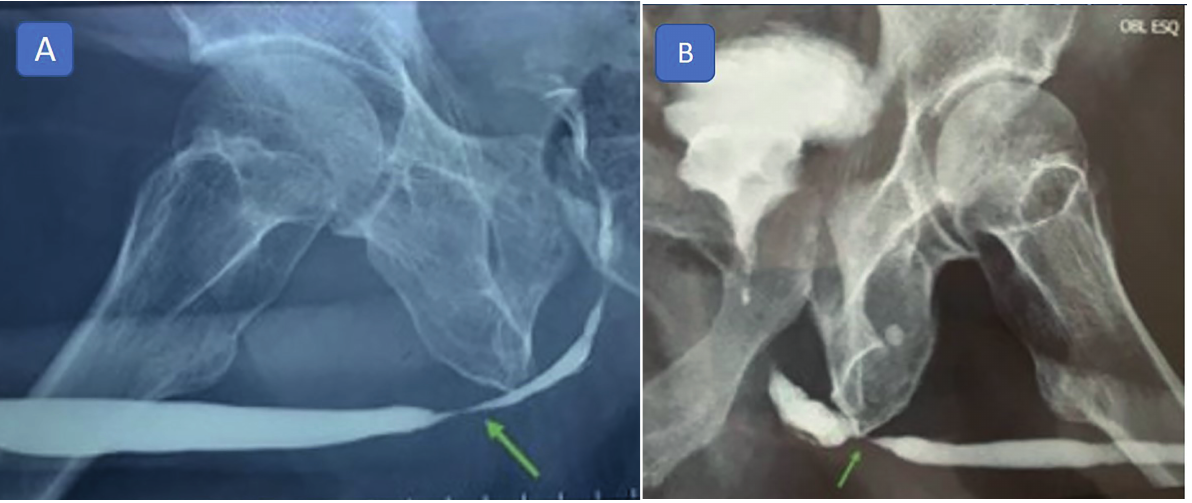
Figure 2 - Voiding cystourethrogram: (A) Case 1 - Male, 67-year old, with a history of straddle injury to the urethra presented with penobulbar urethral stricture, (B) Case 2 - Male, 59-year old, with a history of symptomatic benign prostatic hyperplasia was submitted to transurethral resection of the prostate twice, presenting recurrent bulbar urethral